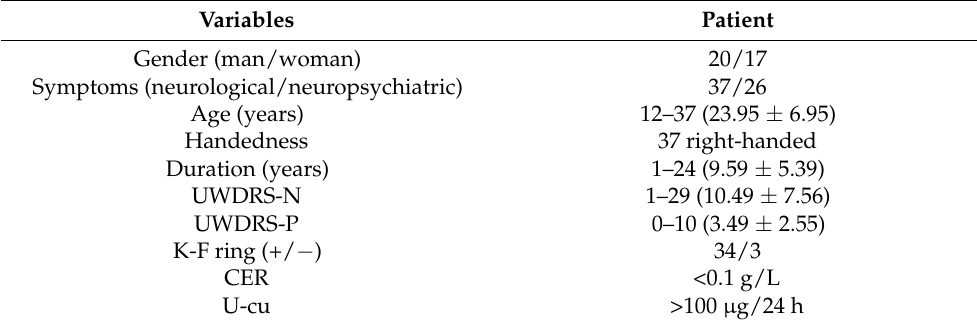
Table 1. General and clinical characteristics of the included WD patients.